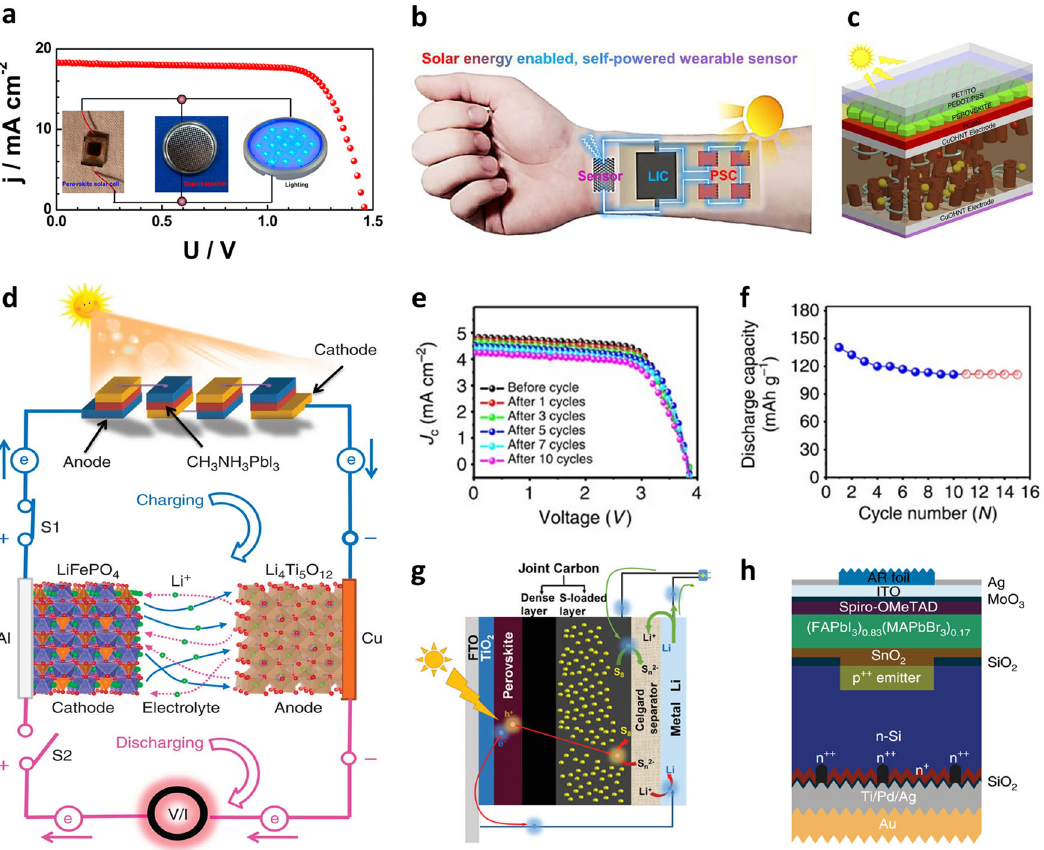
Fig. 10 Perovskite solar cells for energy storage devices. a J – V curves of an integrated system using a CH 3 NH 3 PbI 3 based PSC and a polypyrrole-based supercapacitor (supercapacitor was charged at 0.6 V). Inset: Connection of the integrated system. a Adapted with permission from ref. 142 , Copyright